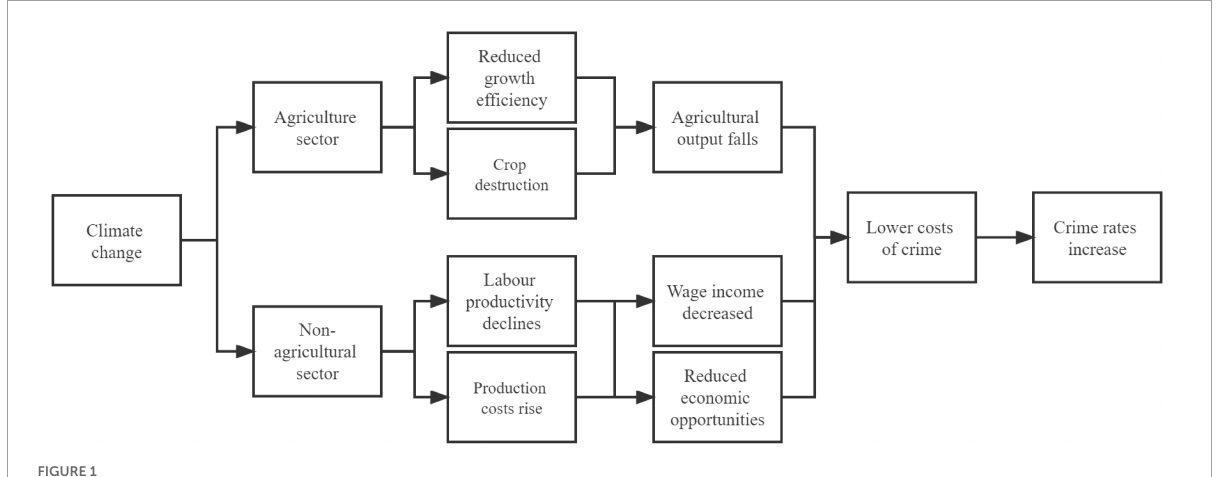
FIGURE1 Mechanisms of climate change increasing crime